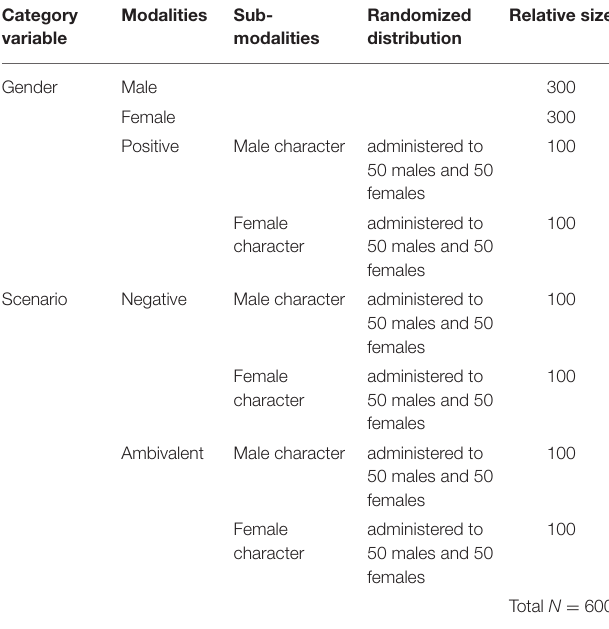
TABLE 1 | Characteristics of the participants. Gender